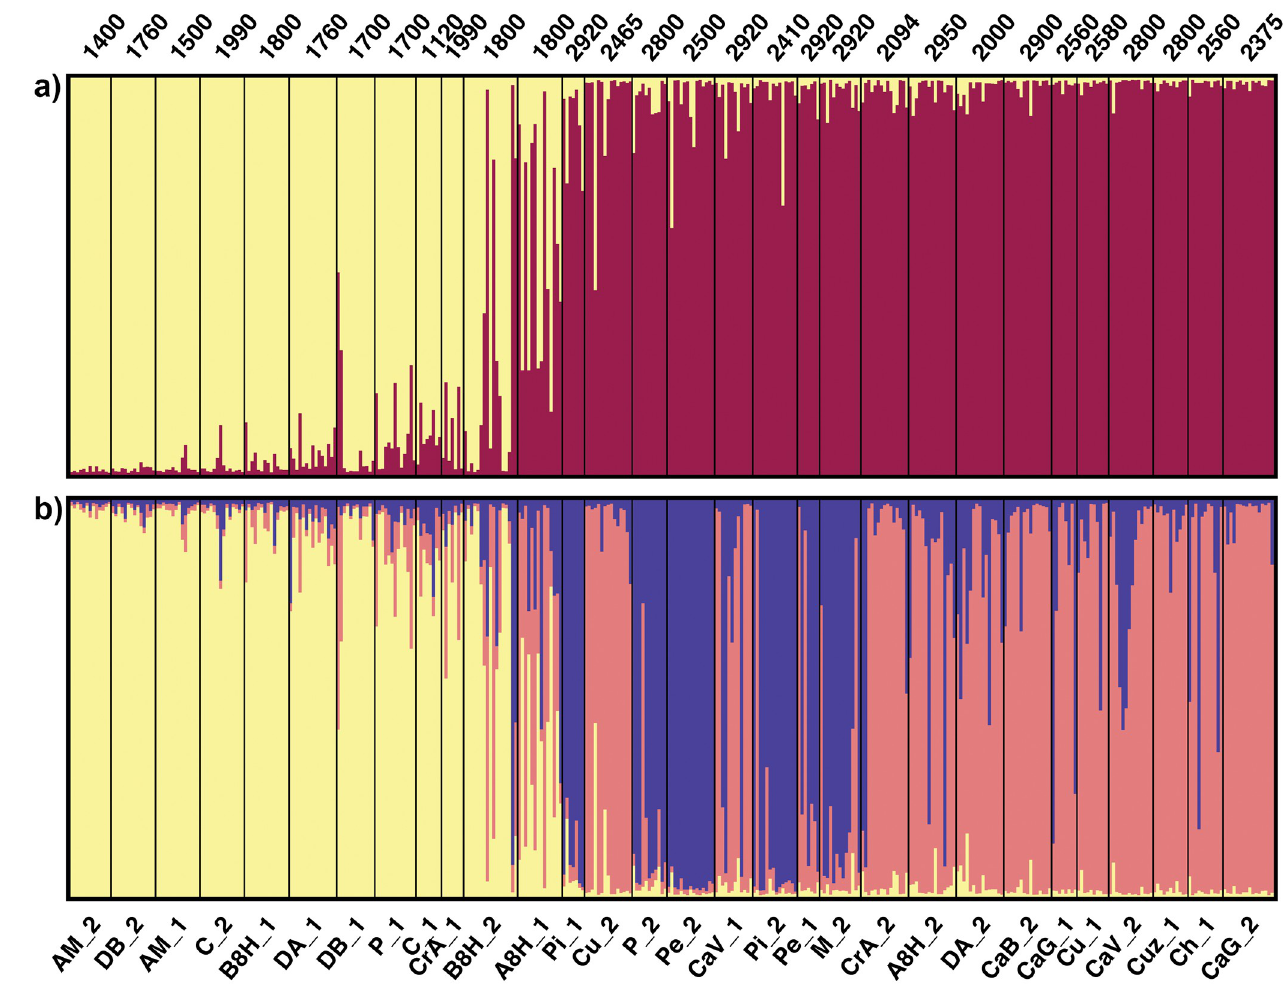
Fig 3. Population structure of maize accessions from Northwestern Argentina (NWA). (a) STRUCTURE bar plot for K = 2. (b) STRUCTURE bar plot for K = 3. Each vertical line represents an individual and colors represent their inferred ancestry from K ancestral populations. Accessions are ordered by altitude of the collection